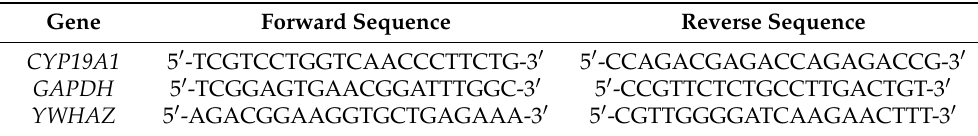
Table 1. Sequences of primers used in real-time qPCR.